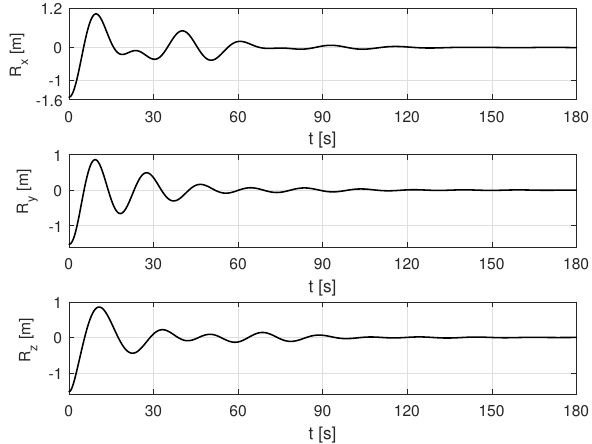
Figure 8. Position of the center of